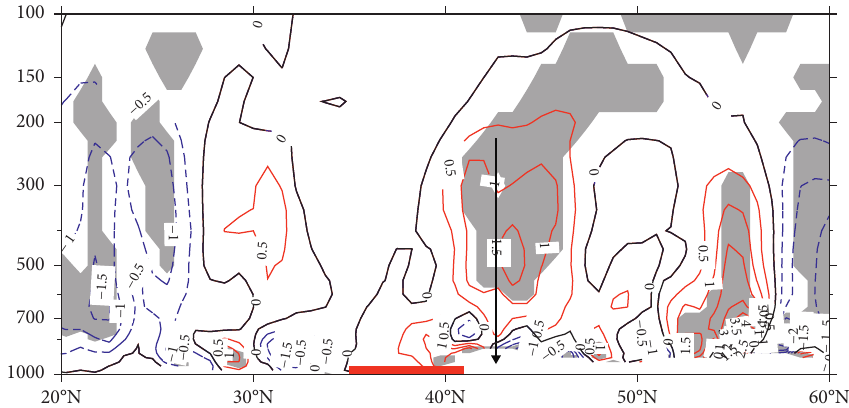
Figure 9: Latitude-height cross section of difference of vertical velocity along 116.25 ° E in JA by 1997–2016 mean minus 1979–1996 mean (unit: 10 − 2 Pa/s). Shaded areas are statistically significant at the 95% confidence level according to Student’s t -test. The red line shows North China.